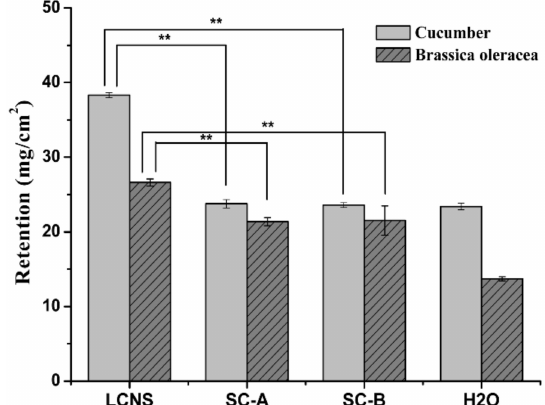
Figure 6. Retention of different lambda-cyhalothrin formulations on cucumber and brassica oleracea leaves (one-way ANOVA, followed by an LSD test, ** p <